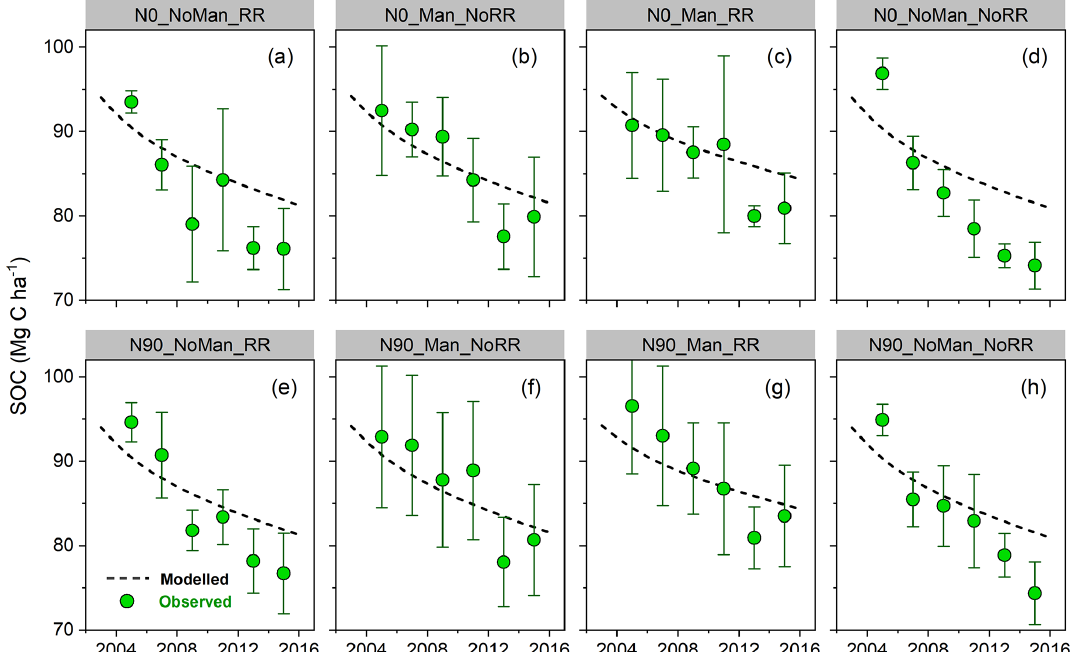
Figure 2. The modelled and observed SOC stocks (0–150cm) for the evaluation treatments (a–h) at the INM3 site, with two levels of mineral N fertilizer input (N0 and N90). The dashed line is the modelled SOC, and the closed circle represents the observed value (scaled to 150cm depth) averaged by the four replicates in the trials, with standard deviation as given in the vertical bar.